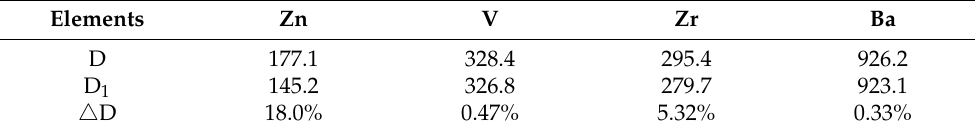
Figure 7. Pedigree diagram of element clustering in samples D ( a ) and D 1 ( b ). Table 6. Comparison element content changes in samples D and D 1 (ppm).